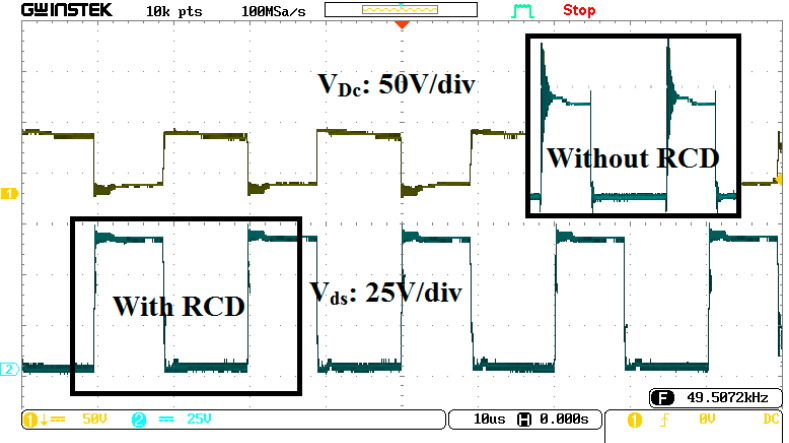
Figure 14. Voltage stress of the MOSFET switch with and without RCD clamp circuit. Figure 15. Voltage stress of the MOSFET switch with and without RCD clamp circuit. Table 4. Power loss distribution of the proposed